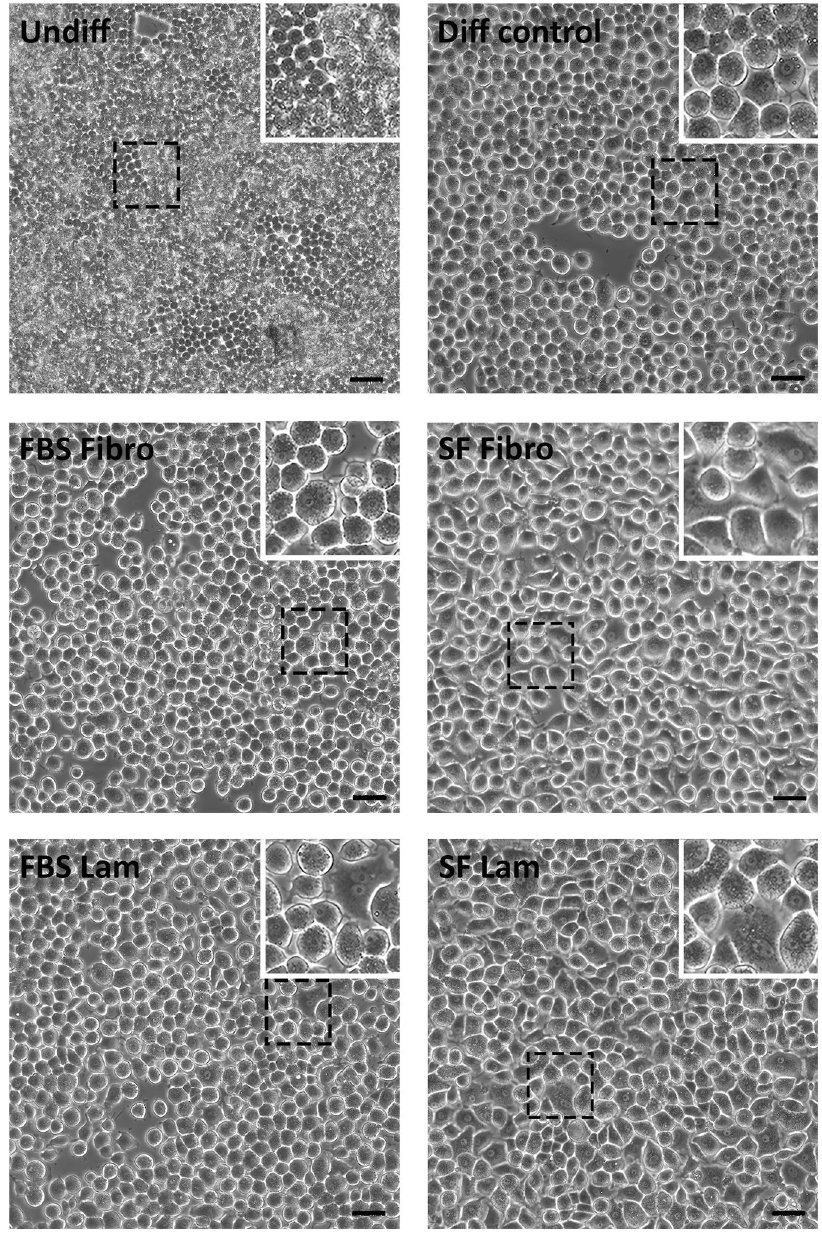
Figure 1. Morphology of undifferentiated AR42J-B13 cells and cells subjected to differentiation-inducing conditions, assessed by phase contrast microscopy on day 4. Undiff - undifferentiated cells; Diff control - differentiation control, with FBS, on plastic; FBS Fibro - differentiation medium, with FBS, on fibronectin; SF Fibro - differentiation medium, serum-free, on fibronectin; FBS Lam - differentiation medium, with FBS, on laminin; SF Lam - differentiation medium, serum-free, on laminin. Scale bar = 50 µ